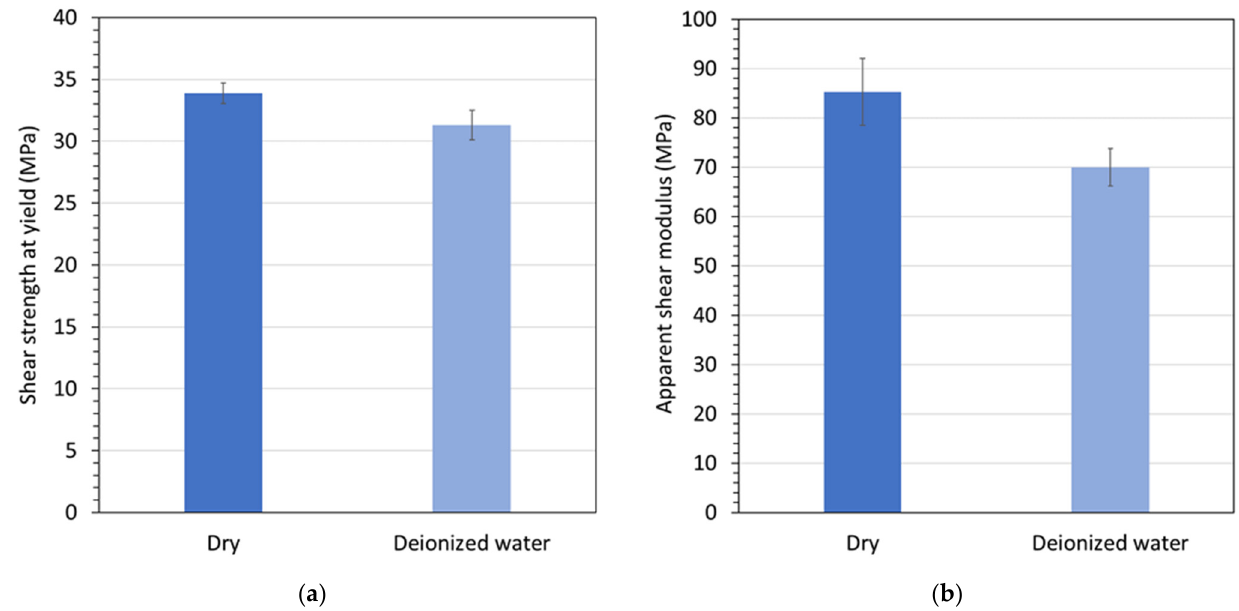
Figure 8. ( a ) Shear strength at yield and ( b ) apparent modulus for Polymer C conditioned and tested at 82 °C in air and in deionized water. at 82 ◦ C in air and in deionized